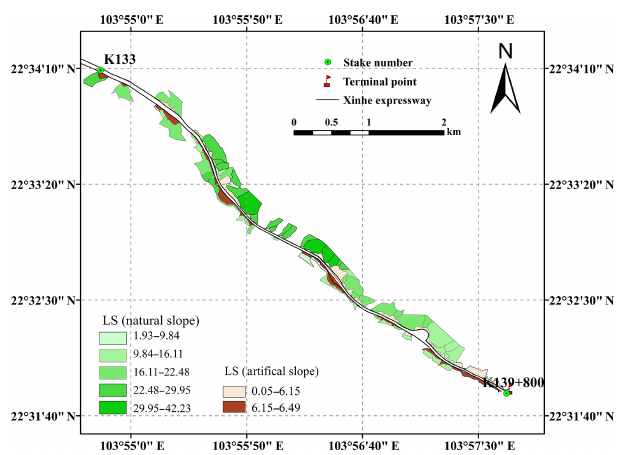
Figure 7. Spatial distribution map of topographic factors (K134– K139).